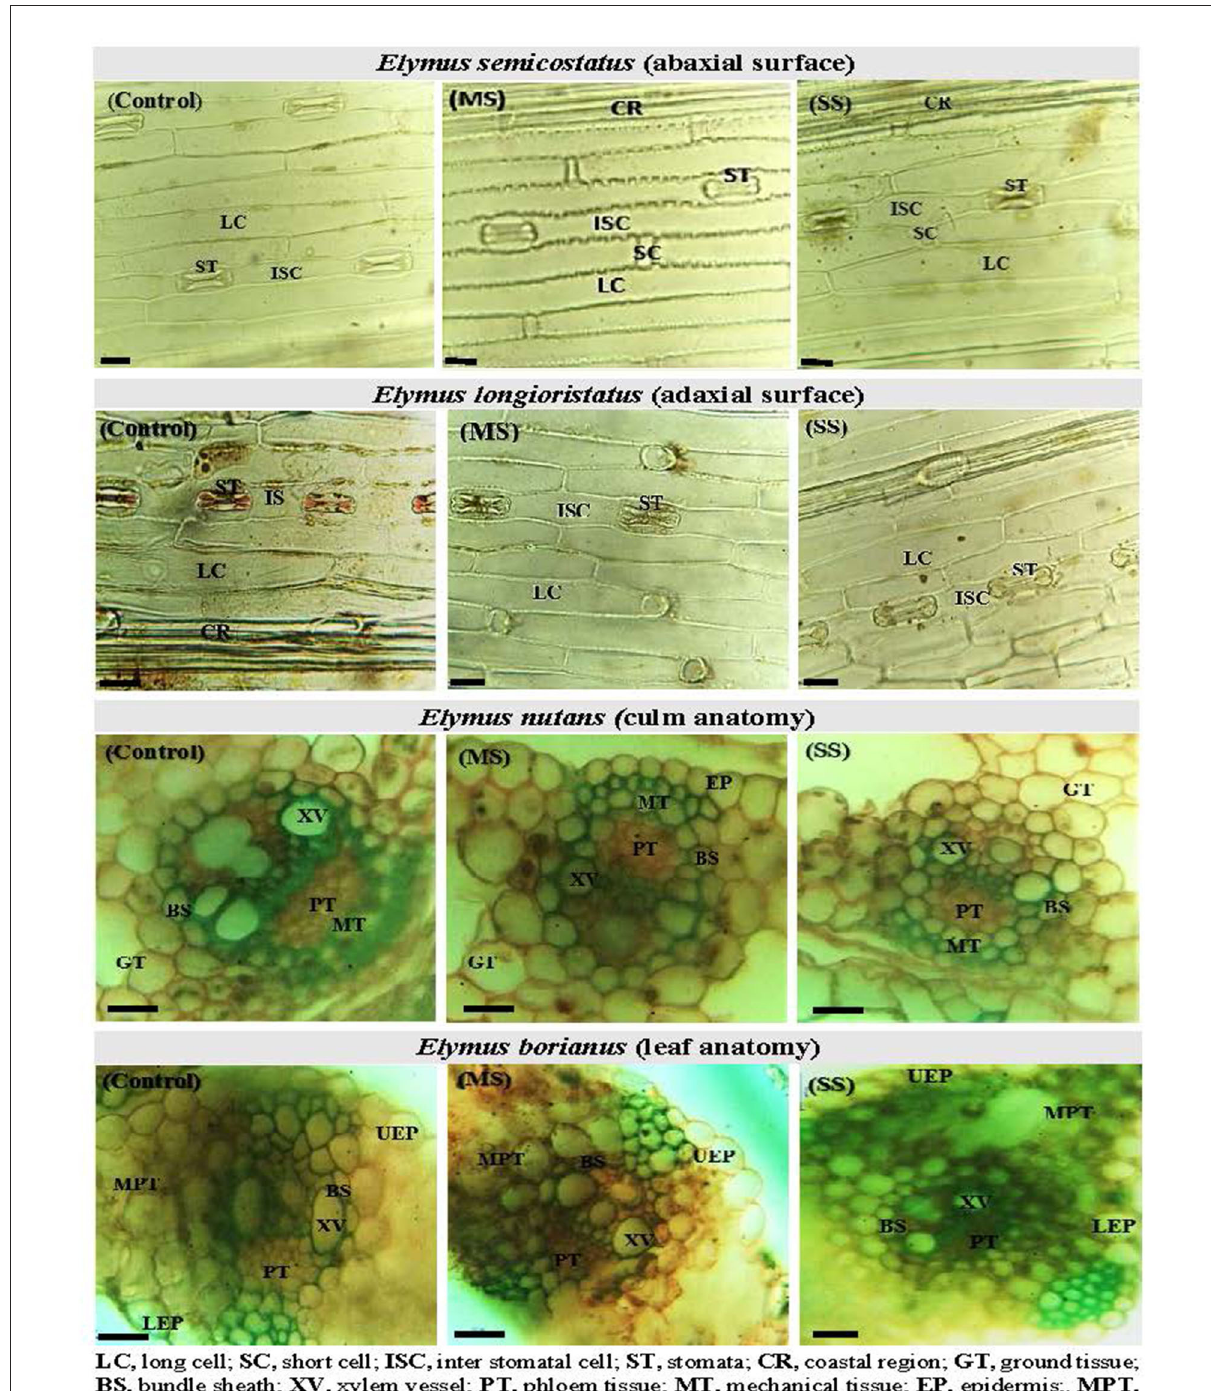
FIGURE1 Leaf epidermal anatomy (abaxial surface and adaxial surface) of Elymus longioristatus ; culm and leaf anatomy of E. nutans under control (C), moderate (MS), and severe (SS) water stress conditions. Bar scale 100 µ m.